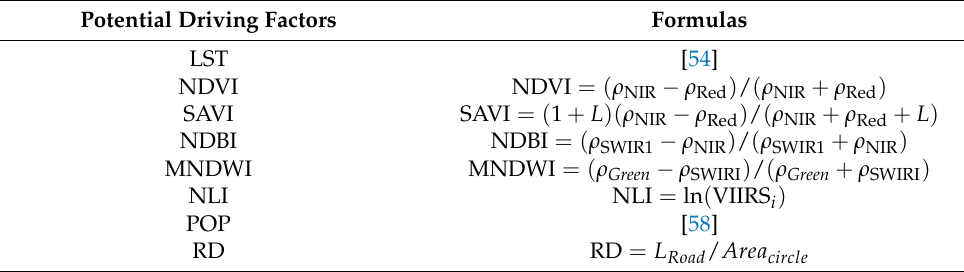
Table 2. Factors used in the geographic detector and their calculation formulas.